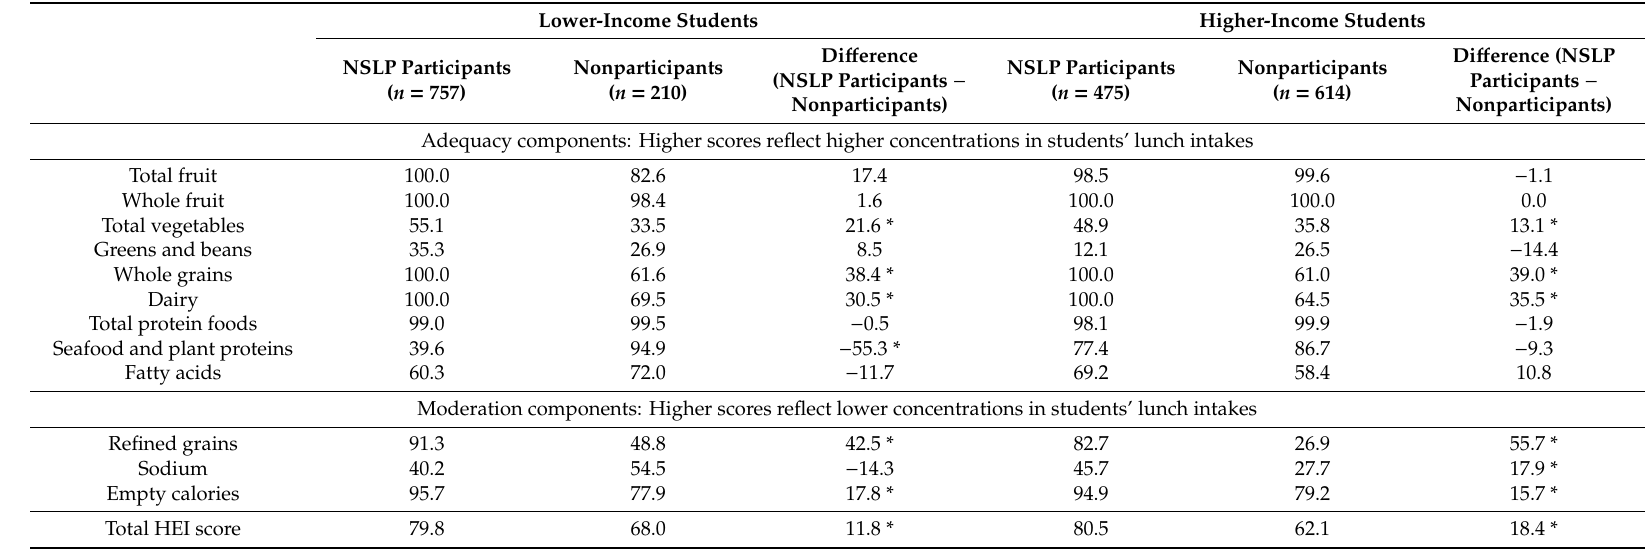
Table 3. Di ff erences between NSLP participants and nonparticipants in mean HEI-2010 scores for lunch intakes, by household